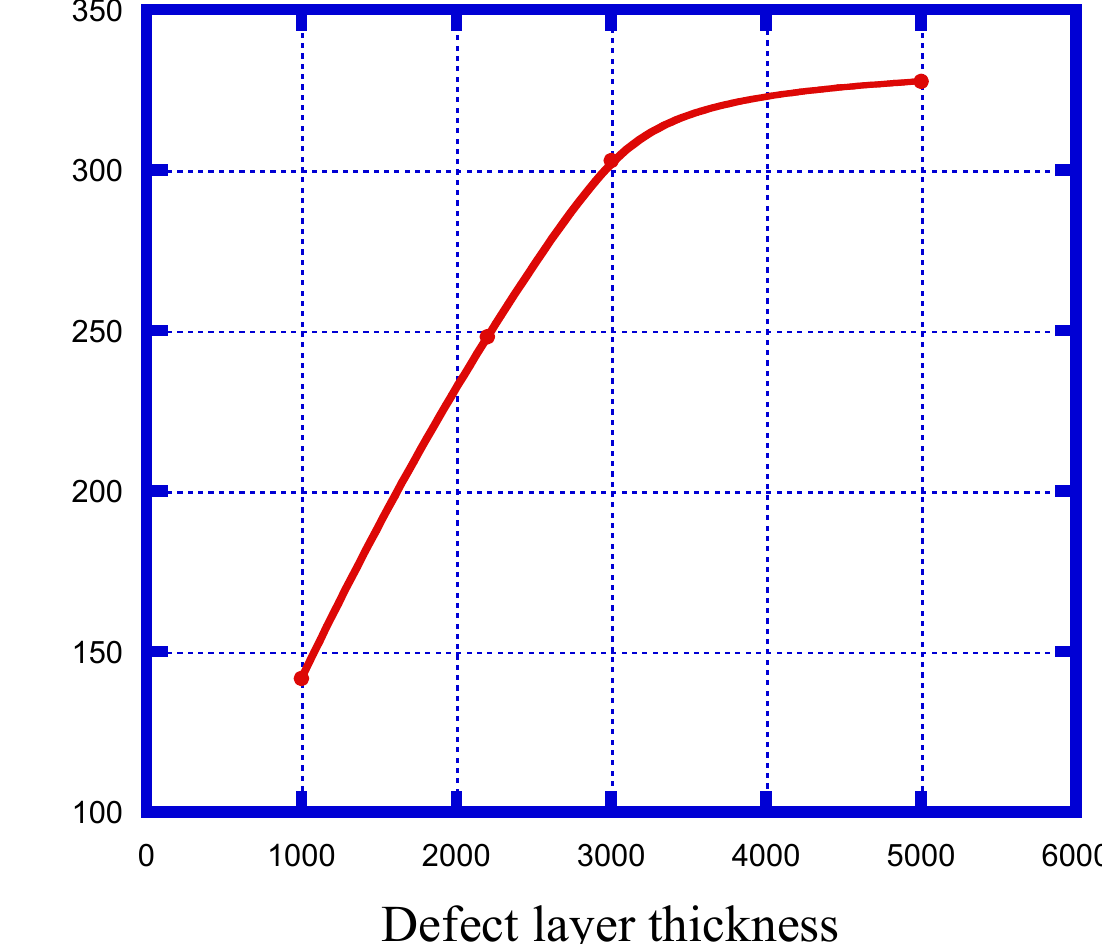
Figure 9. Variation of sensitivity with respect to defect layer thickness.